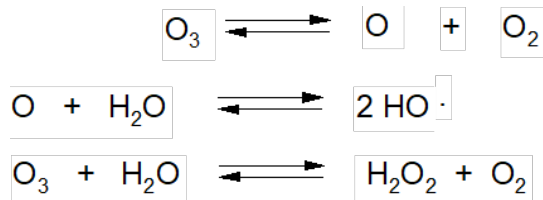
Figure 6. Reactions of ozone decomposition in water.